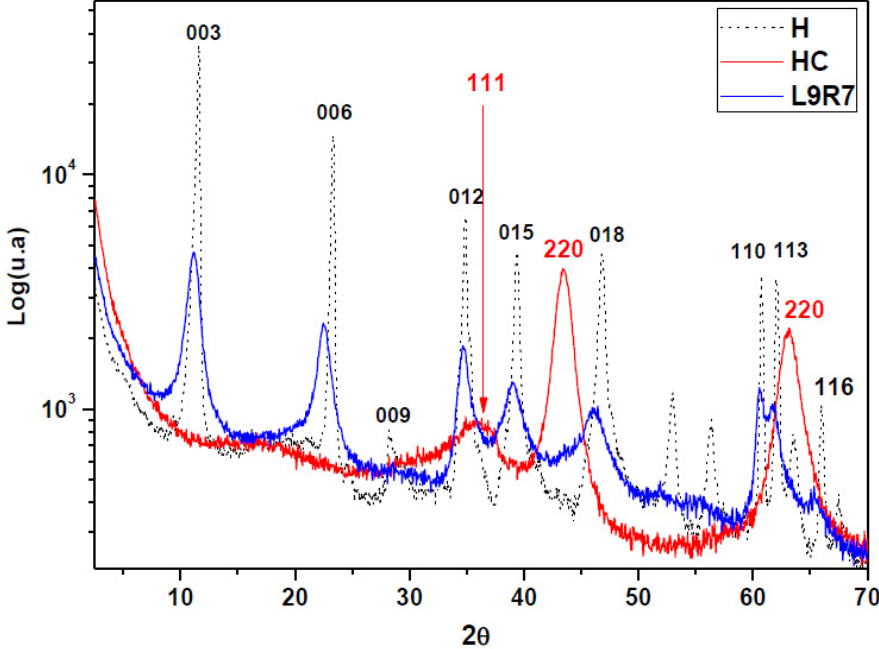
Figure 10. XRD from Hydrotalcite after heat treatment, 600 °C, 3 h (HC): original hydrotalcite (HC) and hydrotalcite reconstructed after a natural dye (from beetroot) adsorption in different bath conditions (L9R7).